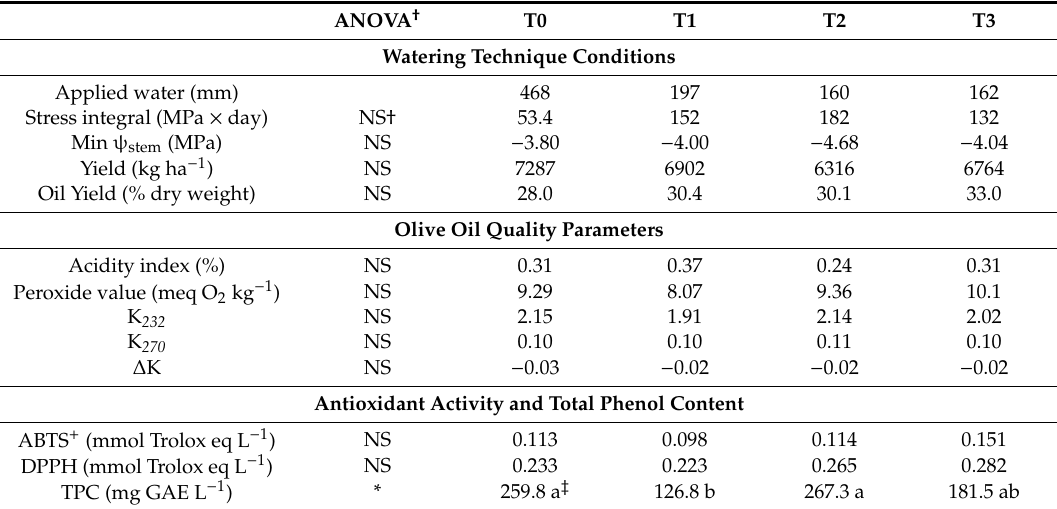
Table 1. Watering technique conditions, oil technological parameters, antioxidant activity (ABTS +